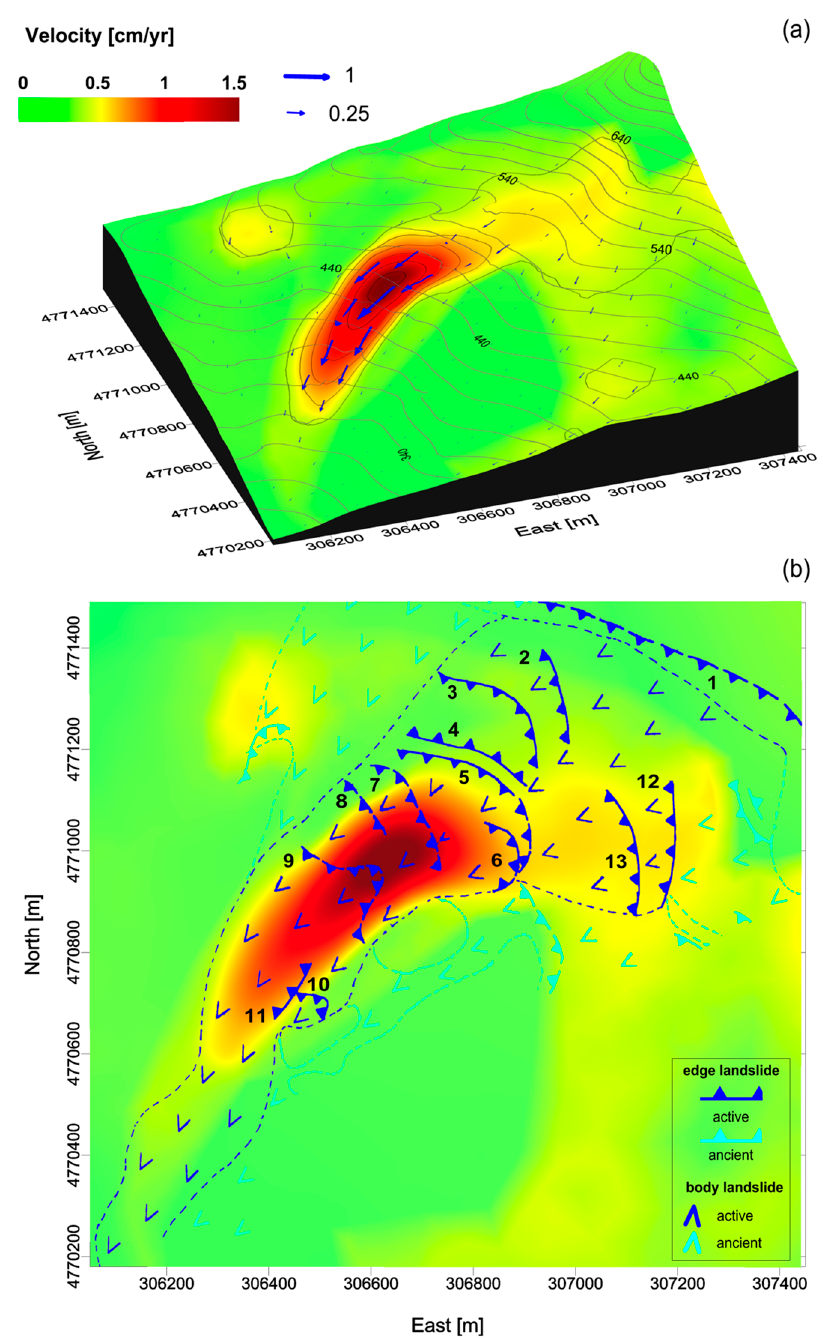
Figure 6. Analysis of FE Model results: ( a ) 3D view of modeled velocity vectors (blue arrows superimposed on the contour lines of the velocity field; ( b ) Modeled velocity map compared with the geomorphological evidences represented by the quiescent (cyan) and active (blue) elements as proposed by Pontoni [23,24].